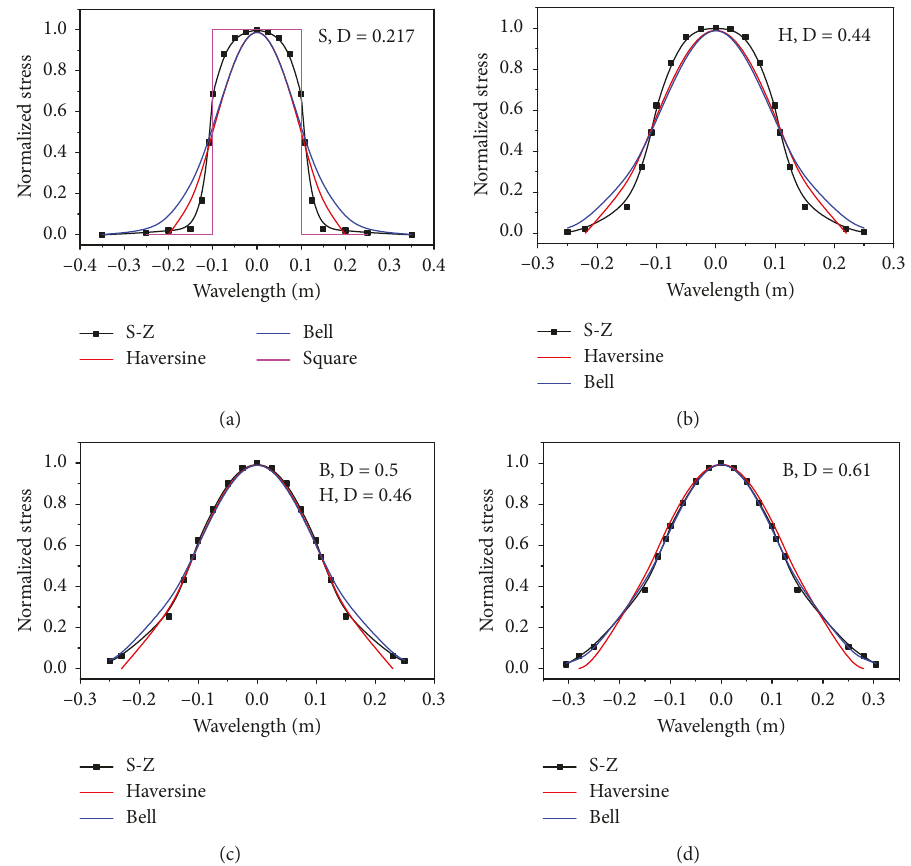
Figure 3: Vertical compressive stress pulse at different depths in the same pavement structure: (a) Z � 0cm, (b) Z � 5cm, (c) Z � 10cm, and (d) Z � 17.8